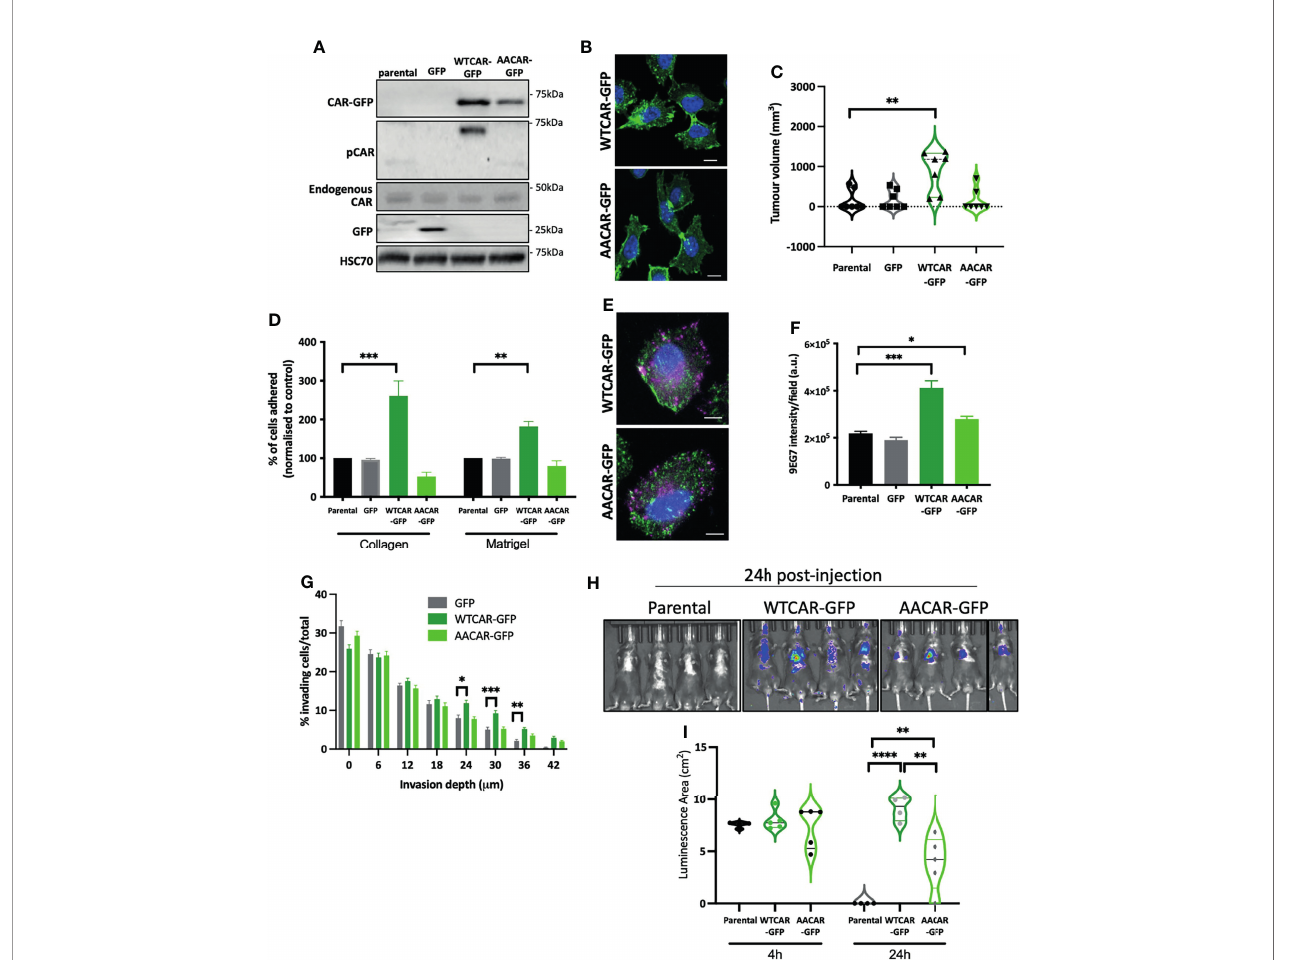
FIGURE 3 | CAR promotes adhesion and invasion in mesenchymal cells. (A) Representative Western blots of speci fi ed proteins in LLC cells, parental, GFP expressing, WTCAR-GFP and AACAR-GFP. (B) Representative confocal images of WTCAR-GFP and AACAR-GFP expressing LLC cells. CAR is shown in green and DAPI in blue. Scale bars are 10 m m. (C) Tumor volume in mice subcutaneously injected with speci fi ed CMT 167 cells. Violin plots shown with each point represents one animal (n=7-8 per group). (D) Graphs showing % adhesion to collagen and Matrigel of indicated cell lines 2h post-plating. Data is from 3 wells per cell line, representative of 3 independent experiments. (E) Representative confocal images of WTCAR-GFP and AACAR-GFP LLC cells (CAR; green) stained for active b 1 integrins (9EG7; magenta). Scale bars are 10 m m. (F) Quanti fi cation of images of speci fi ed cell lines stained for active b 1 integrins (9EG7). Data is from at least 10 fi elds of view (5-10 cells per fi eld) per condition. Representative of 3 independent experiments. (G) Quanti fi cation of inverted invasion data from speci fi ed cell lines at different depth intervals, pooled from 4 different wells per condition, representative of 3 independent experiments. (H) Images of indicated cell lines expressing luciferase 24 hours after intravenous injection into animals. Representative of 2 independent experiments. (I) Quanti fi cation of data as in (H) . Violin plots shown with each point represents one animal (n=4-5 per group). All values are mean ± SEM. P values *p < 0.05, **p < 0.01, ***p < 0.0005, ****p <